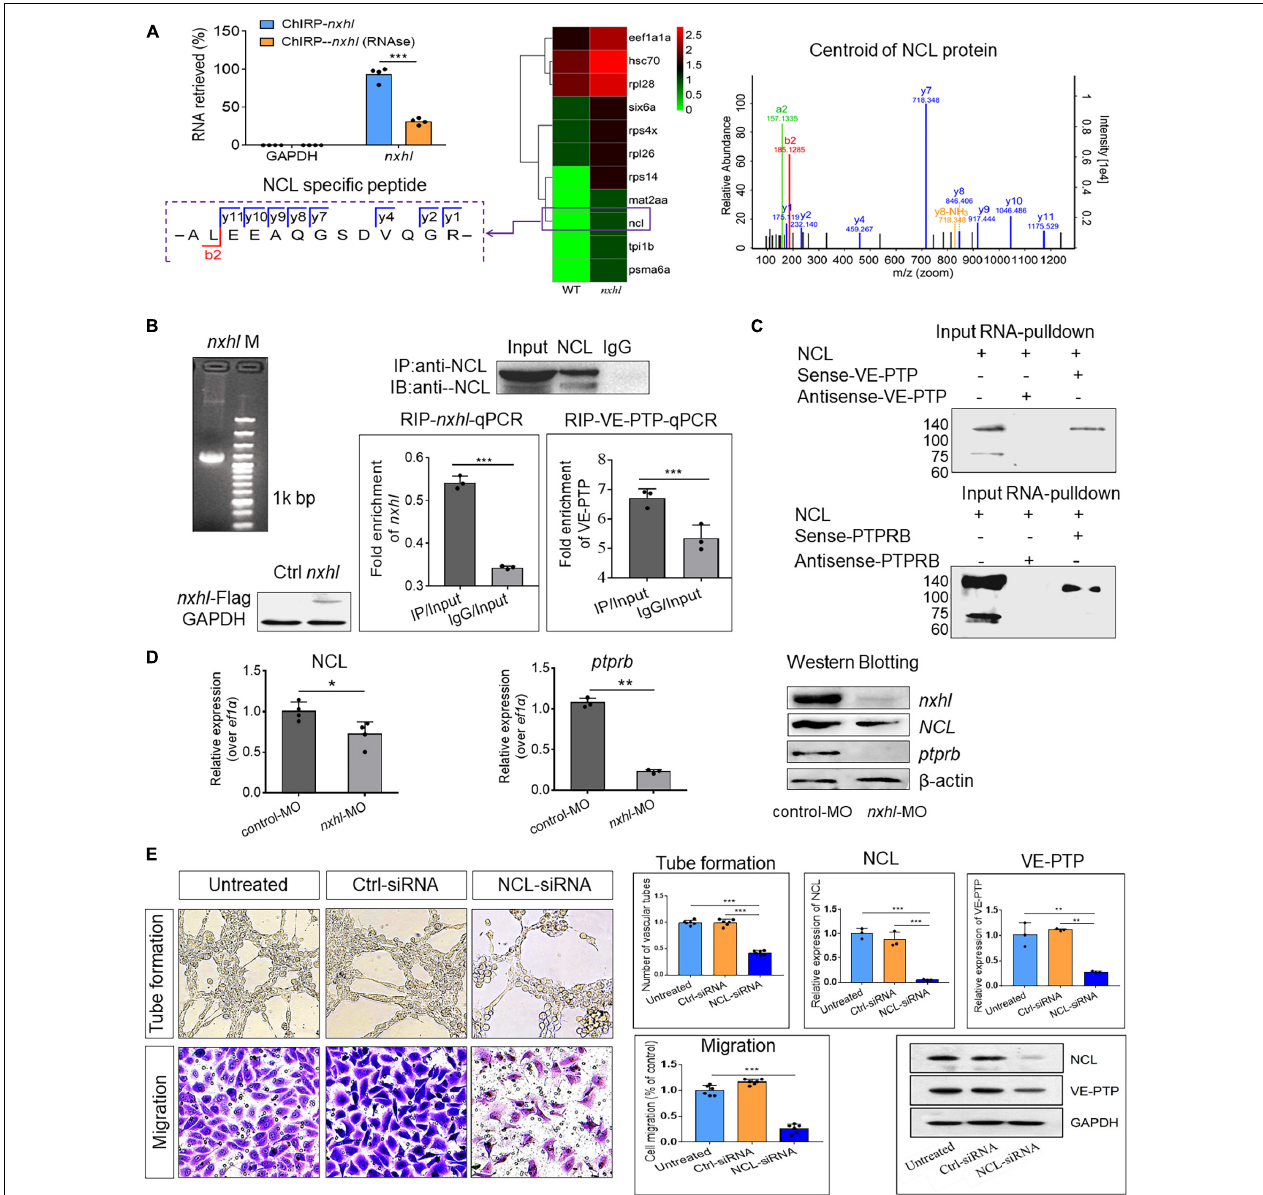
FIGURE 6 | Nxhl regulates VE-PTP ( ptprb ) through interactions with NCL. (A) ChIRP-MS identification of nxhl RNA binding proteins using zebrafish tissues. qPCR identification of nxhl RNA in the eluted RNAs. Graph shows more than 90% nxhl RNA was retrieved, and no GAPDH was detected. Heat map shows major proteins are enriched and significantly (change fold > 2 and p < 0.05) retrieved by nxhl and control probes, analyzed by LC/MS-MS. NCL protein (purple boxed) was selected as candidate for follow-up study. The Centroid of NCL protein shows that NCL protein is pulled down and identified by LC/MS-MS. The specific peptide identifies NCL protein. (B) The interaction between nxhl, VE-PTP mRNA and NCL protein by RIP-qPCR assay. The mRNA expression of nxhl was determined by qPCR and Western blotting against Flag antibody and used to identify the successful expression of pcDNA3.1- Flag- nxhl plasmid in 293T cells. Bars show the interaction between nxhl mRNA and NCL protein. The interaction between VE-PTP mRNA and NCL protein is shown too, and qPCR shows the detection for VE-PTP mRNA expression in the NCL-pulled down RNA. (C) The interaction between nxhl, VE-PTP mRNA and NCL protein by pull down assay. Gels show the interaction between VE-PTP mRNA and NCL protein. Western blotting was performed to detect NCL protein in the VE-PTP-biotin probe -pulled down proteins in 293T cells. The interaction between ptprb mRNA and NCL protein is shown too. (D) Loss of nxhl affects the expression of NCL at both mRNA and protein levels. The mRNA expression of NCL and ptprb were determined by qPCR. The total NCL protein, total nxhl and ptprb protein in zebrafish tissues from knock-down group and control were detected by Western blotting using specific antibodies (details see Materials and methods). β -actin was used as internal control. (E) Silence of NCL inhibits angiogenesis and expression of VE-PTP. The tube formation and cell migration potential of HUVECs treated with NCL-siRNA was determined by using transwell chambers as described in the “Materials and methods” section. Scale bars, 20 µ m. Representative images of cells stained in NCL-siRNA treated HUVEC cells. The expression of NCL and VE-PTP was quantified by qPCR. Protein levels of NCL and VE-PTP were examined by using Western blotting post silence of NCL. GAPDH antibody was used as internal control. The data represent as mean ± SEM from three independent experiments. * p < 0.05, ** p < 0.001, ***p < 0.0001 represents statistically